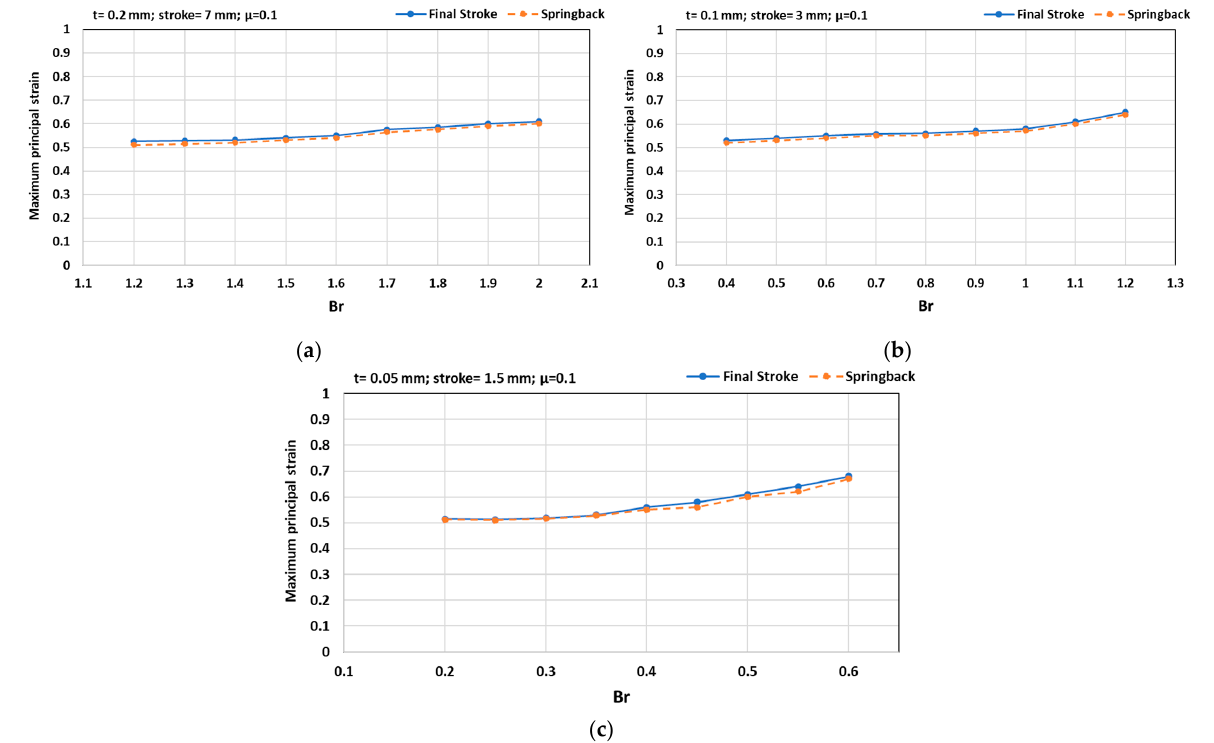
Figure 8. The relationship between the fillet radius of the hole and maximum principal strain of the flange: ( a ) Model 1; ( b ) Model 2; ( c ) Model 3.